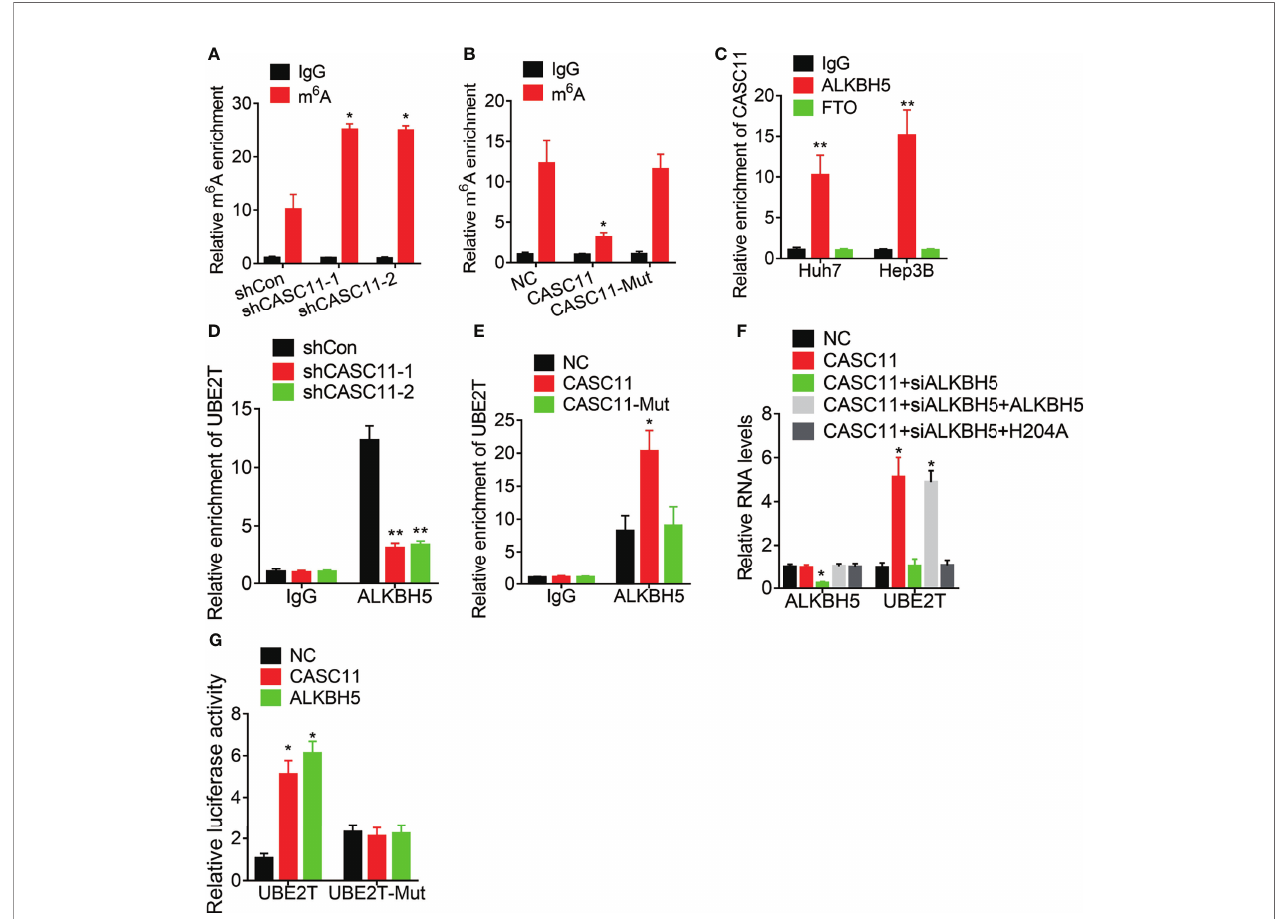
FIGURE 5 | CASC11 decreases the m 6 A modi fi cation ofUBE2T mRNA via association with ALKBH5. (A) The m 6 A level of UBE2T mRNA in control and CASC11 knockdownHep3B cells was examined byMeRIP assay. (B) The m 6 A level of UBE2T mRNA incontrol and wild-type and mutant CASC11 overexpressingHuh7 cells was examinedby MeRIP assay. (C) The interaction of CASC11 with ALKBH5 orFTO was detected usingRIP assay. (D) The interaction between ALKBH5 and UBE2T mRNA was tested using RIP assay in controland CASC11 knockdownHep3B cells. (E) The interaction between ALKBH5 and UBE2T mRNA was tested using RIP assay in control andwild-typeand mutant CASC11 overexpressingHuh7 cells. (F) The mRNA levelsof ALKBH5 and UBE2T in indicatedHuh7cells. (G) Wild-typeorm 6 A consensus sequence mutant UBE2T (UBE2T-Mut) cDNA was constructed andfused with fi re fl y luciferase reporter pmirGLO. Mutation of m 6 A consensussequences oroverexpression of CASC11 or ALKBH5 enhanced the luciferase activity of UBE2T reporter inHuh7 cells. Data are mean ± SD. *p < 0.05, **p <